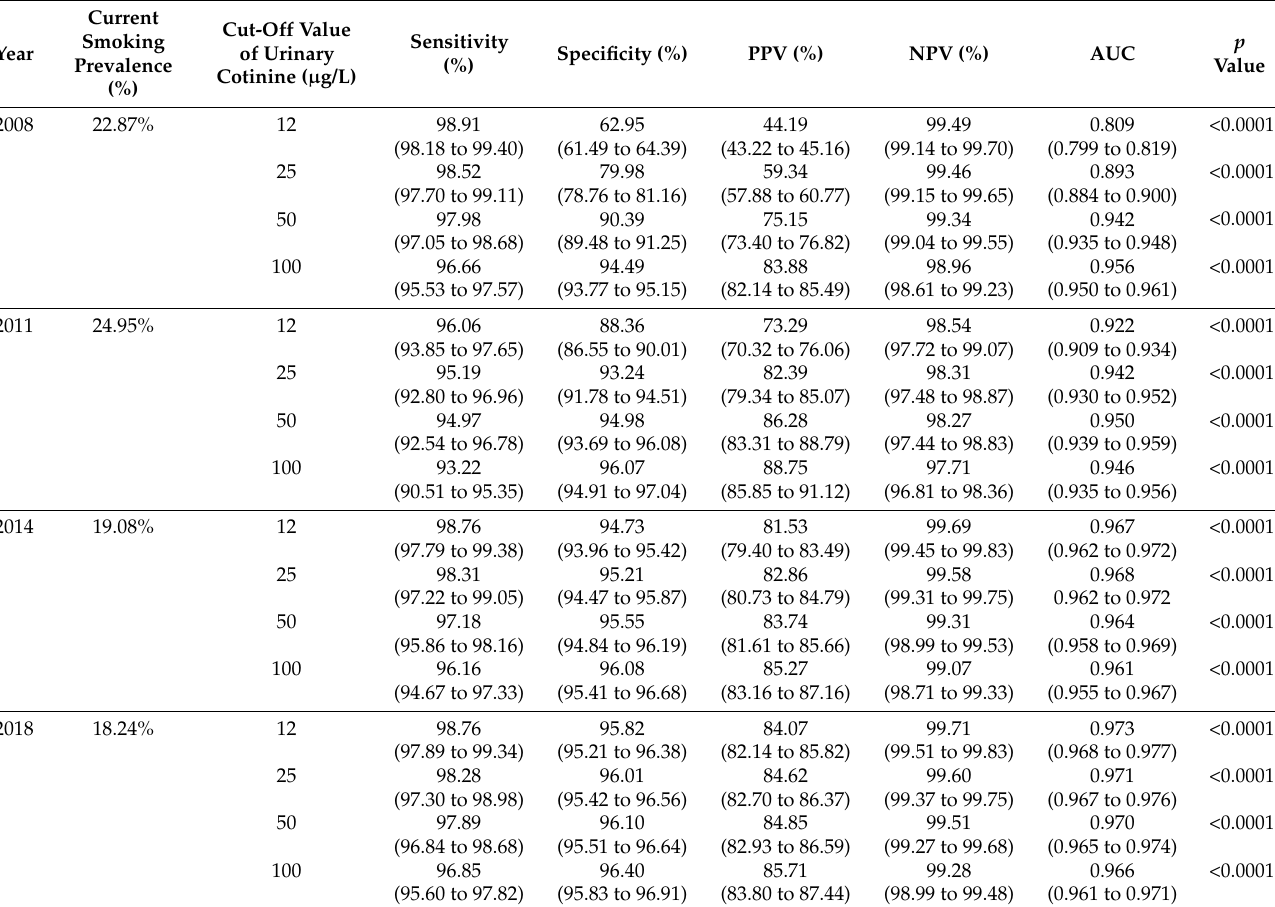
PPV = positive predictive value. NPV = negative predictive value. AUC = area under the curve.